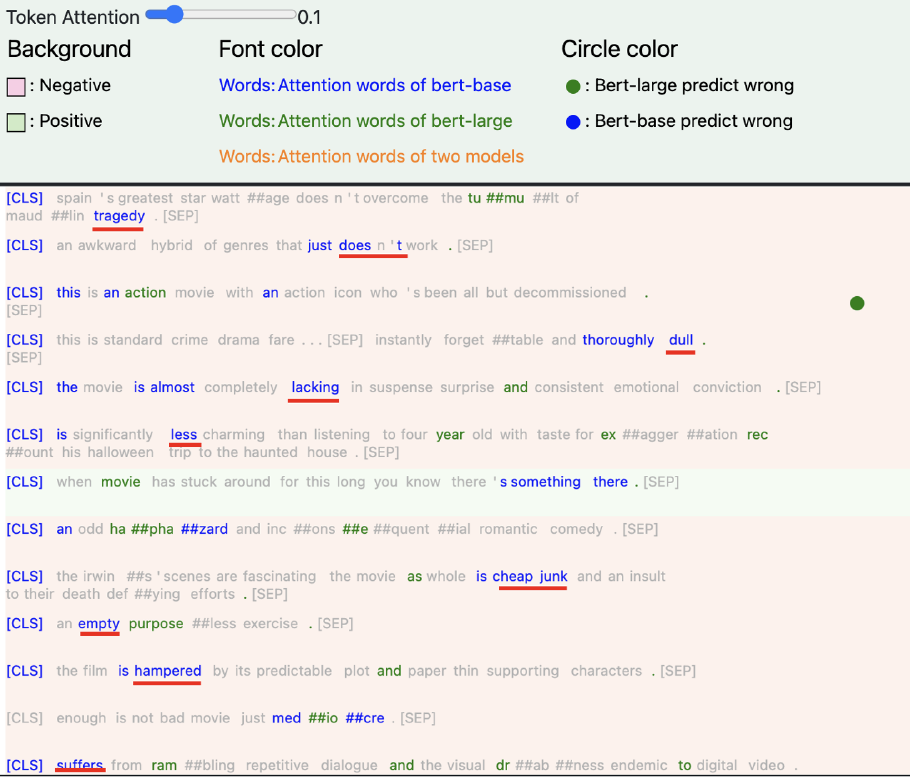
Figure 17. Many negative words are attention words of the bert-base